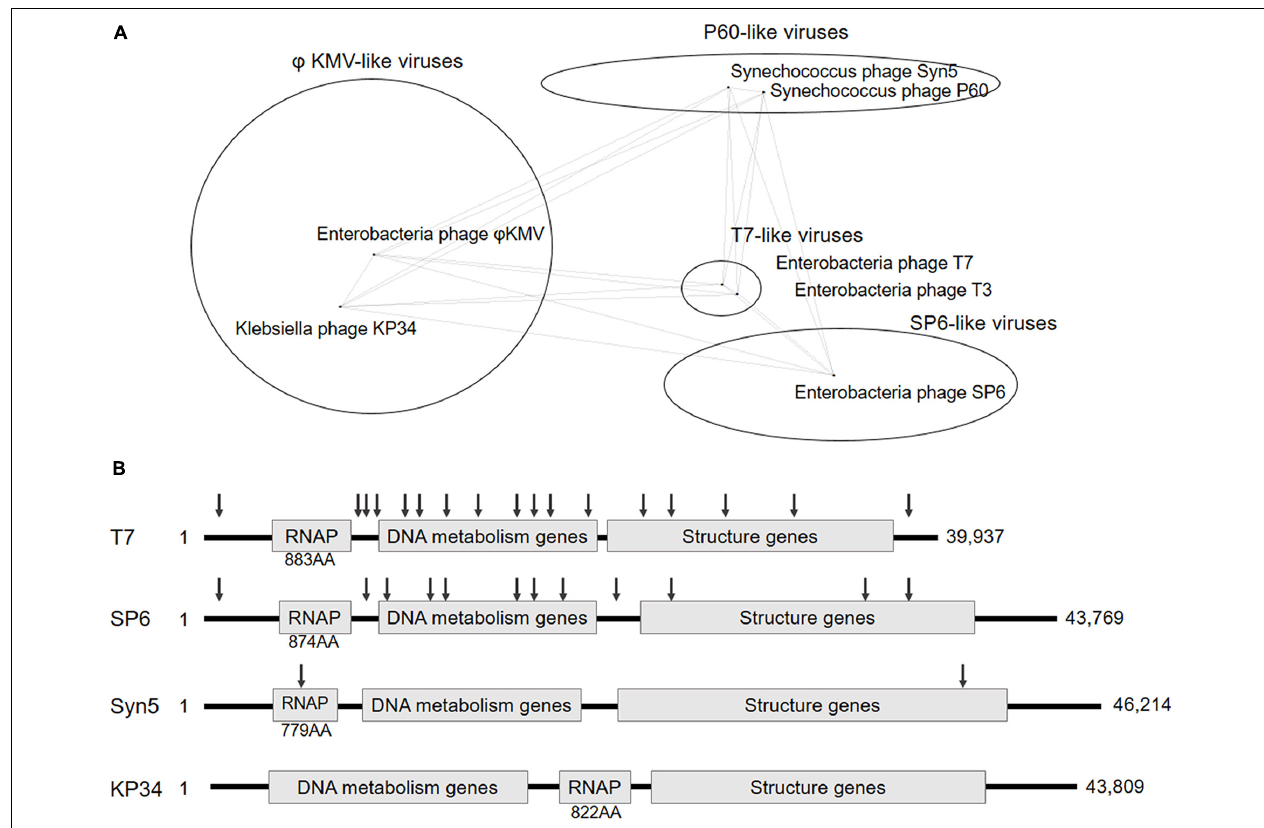
FIGURE 1 | Classification and genome organization of bacteriophages containing ssRNAP. (A) Schematic showing of Autographivirinae clusters based on genome sequence comparison (an inaccurately modified version of Fig. 3 in Drulis-Kawa et al., 2011). (B) Schematic illustration of the genome organization of phage T7, SP6, Syn5 and KP34. The approximate position of T7, SP6, and Syn5 promoters are indicated by down arrows. Size of each RNAP and genome are also